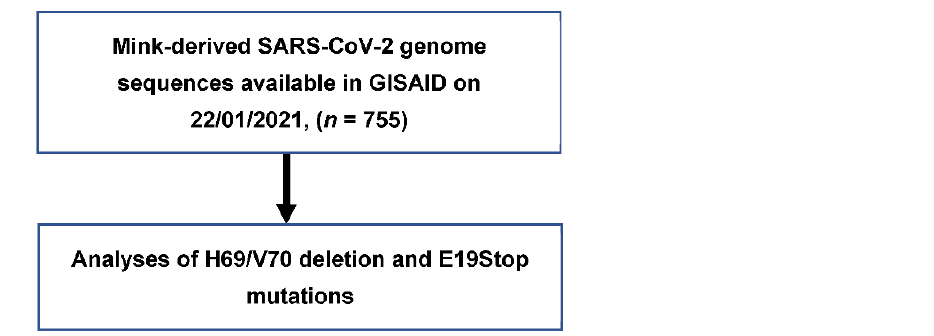
Chart 1. Flow chart of the mink-derived SARS-CoV-2 genome sequence analysis.